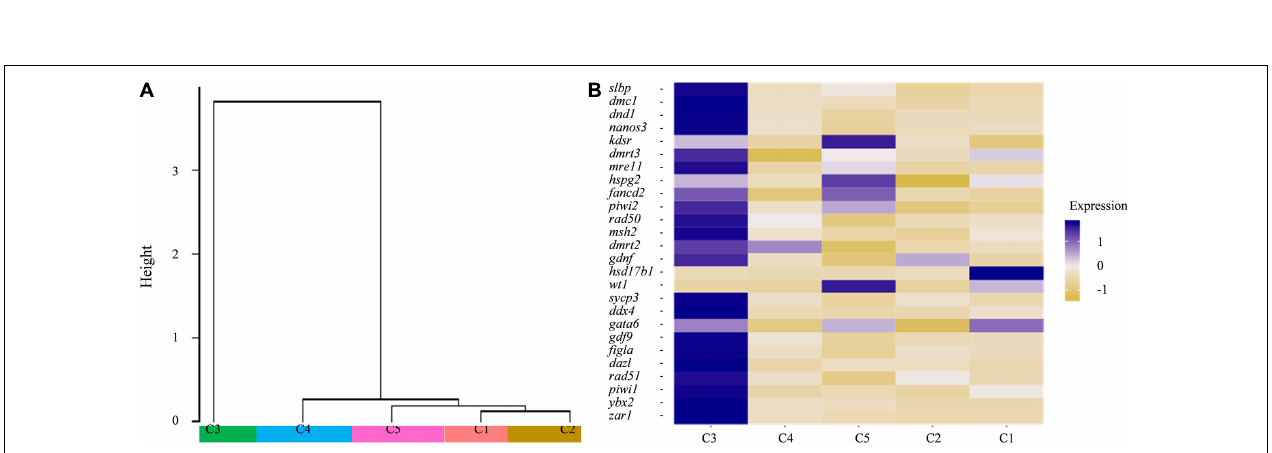
FIGURE 4 | (A) Dendrogram of the Louvain algorithm performed using Seurat-based workflow between five cell clusters. Y -axis represents the distance of the five cell clusters. (B) Heatmap of well-known marker genes of ovarian germ cell and somatic cell. The color key from yellow to blue indicates the relative gene expression level from low to